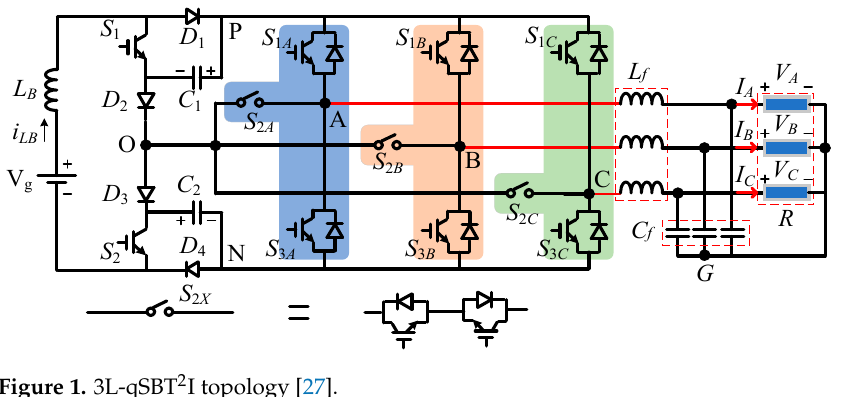
Figure 1. 3L-qSBT 2 I topology [27].